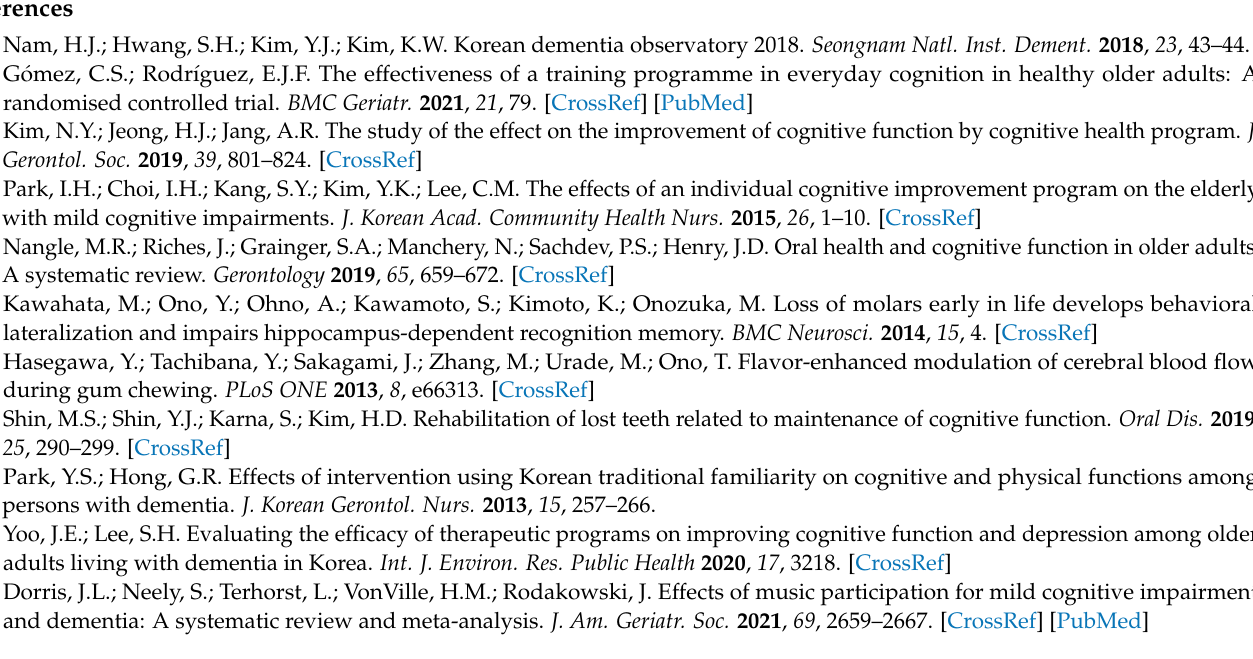
improvement program; Table S2: Details of general characteristics measurements; Table S3: Details of oral health status measurements; Table S4: Details of mental health status measurements; Table S5: Summary of outcome